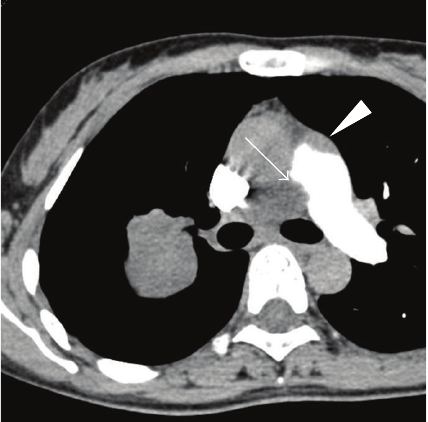
Figure 2: Contrast-enhanced CT showing obstruction of the right pulmonary artery (arrow). A skip lesion was also suspected in the periphery of the pulmonary artery trunk